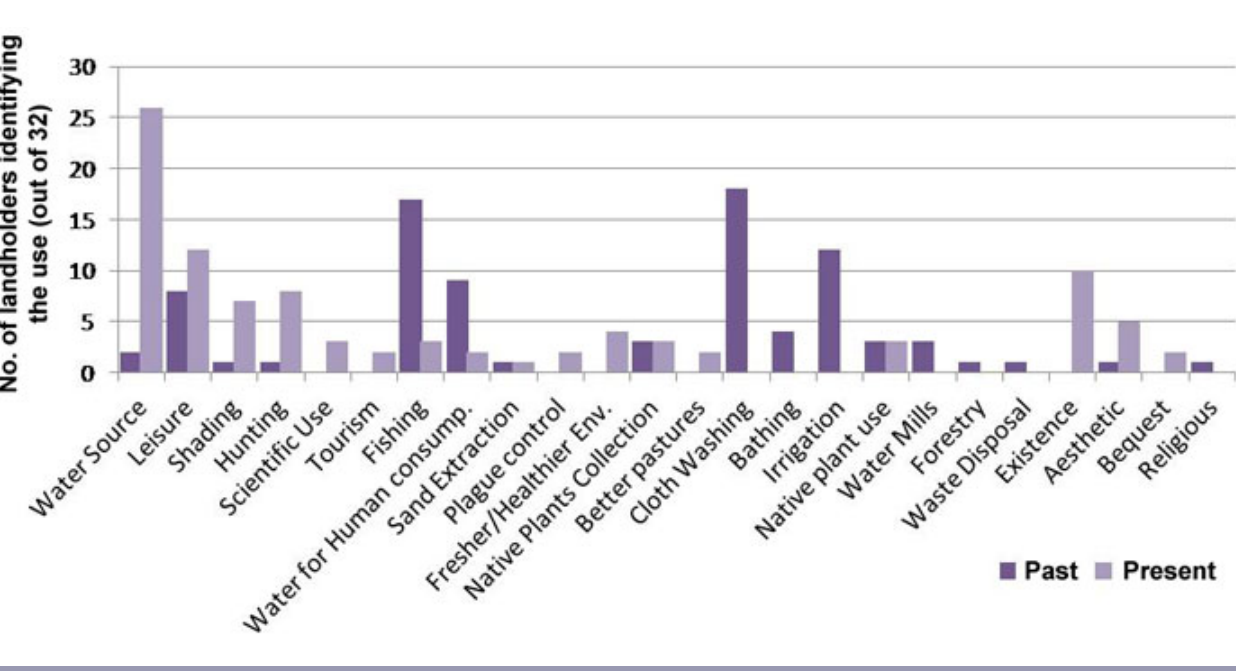
Fig. 3. Stream use by local people over time: past and present values of streams identified by the 32